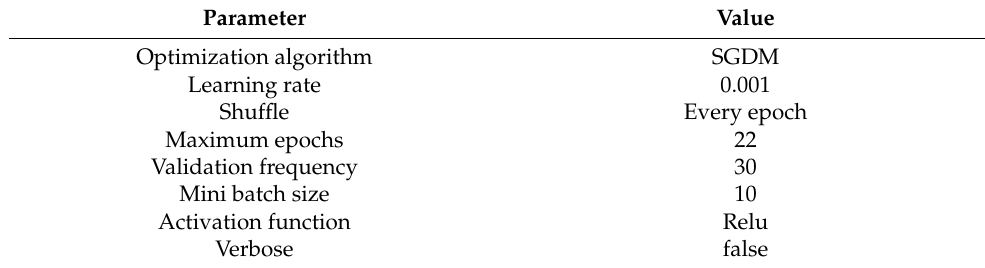
Table 1. Hyper-parameters values. Parameter Value Optimization algorithm SGDM Learning rate 0.001 Shuffle Every epoch Maximum epochs 22 Validation frequency 30 Mini batch size 10 Activation function